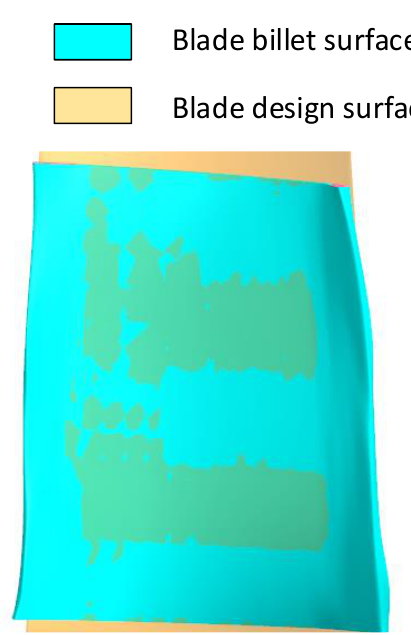
tolerances. The measured points and the blade design surface before the localization are shown in Figure 7.